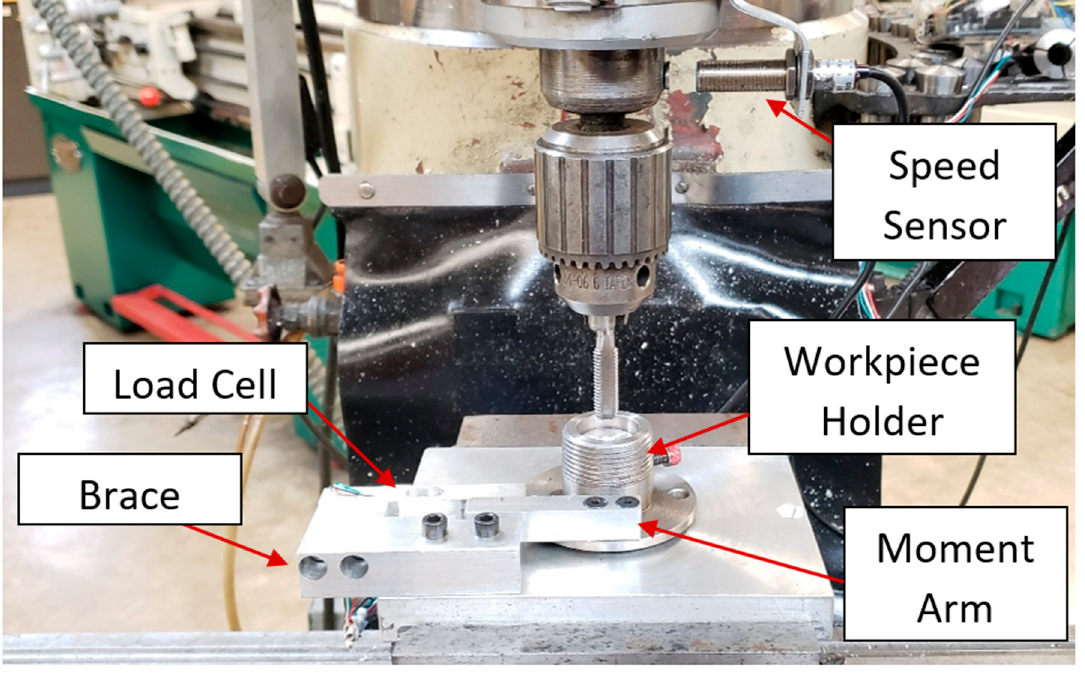
Figure 7. Testing device mounted on a milling machine during tapping torque test.